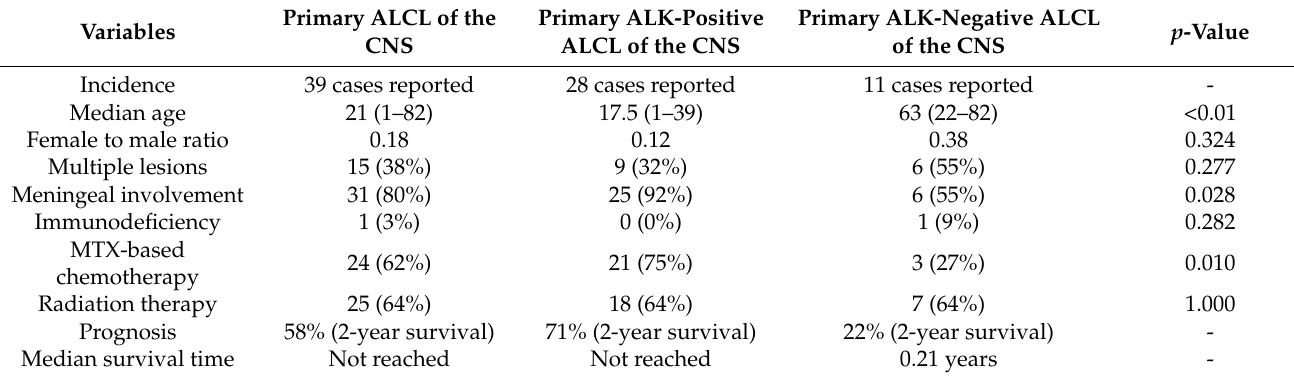
Table 2. Summary of the clinical features of primary anaplastic large cell lymphoma of the central nervous system cases based on past reports, including in comparison to primary central nervous system lymphoma cases.